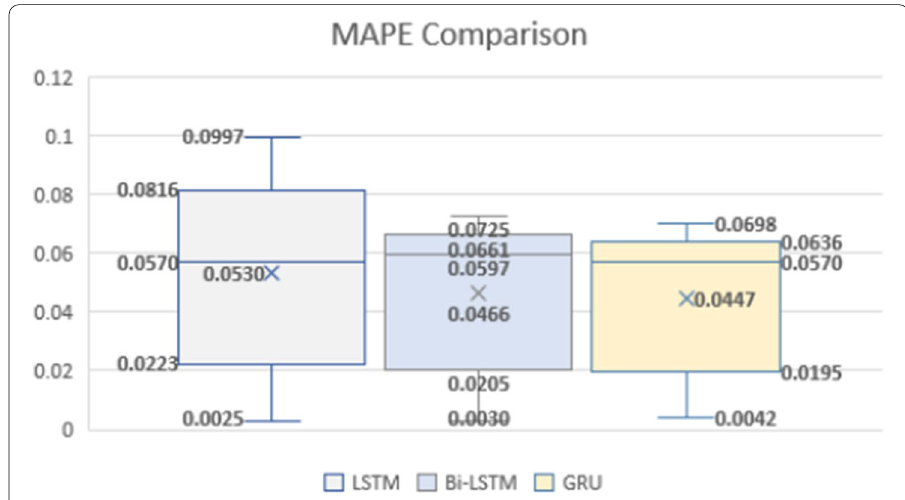
Fig. 8 MAPE comparison of each RNNs deep learning